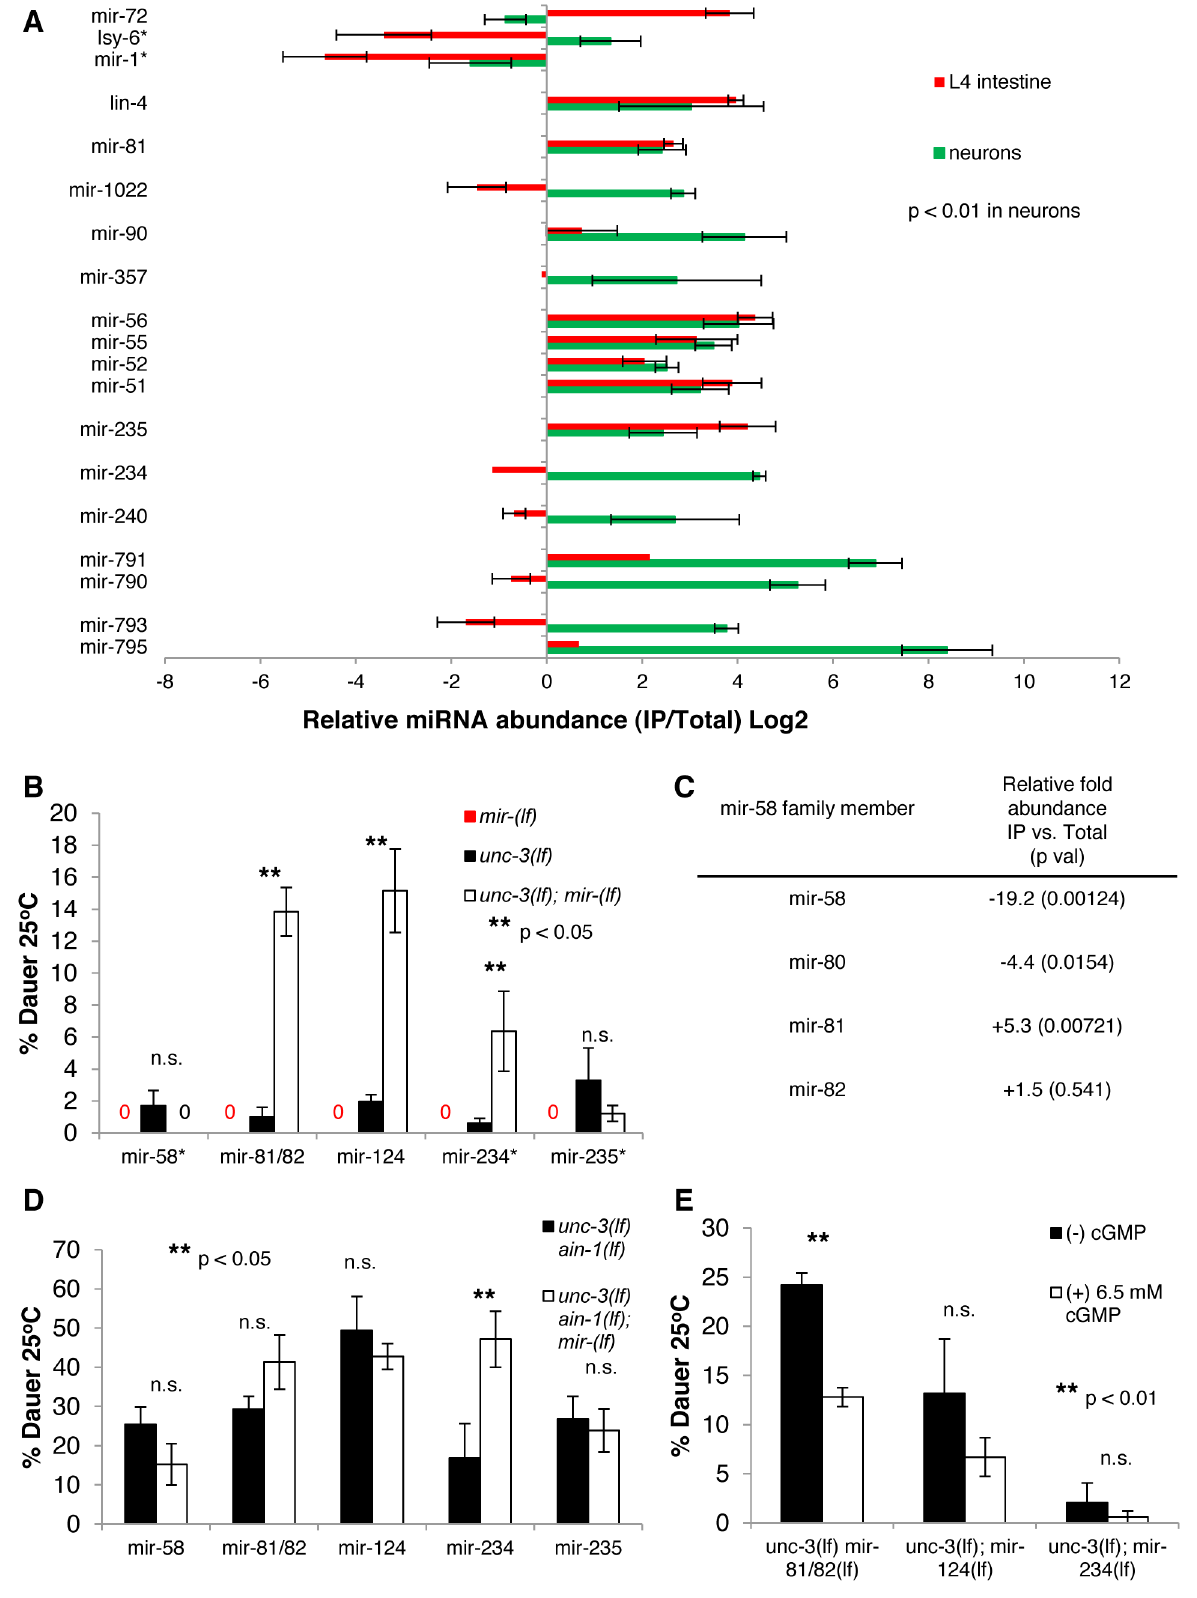
Figure 4. Multiple neuronal miRNAs modulate dauer signaling. A. Bar graph representing the relative abundance of miRNAs enriched in the asynchronous neuronal miRISC IP, with a p , 0.01 determined by a student’s t-test (* except miR-1 and lsy-6). Error bars represent S.E.M. from four biological replicates. B. Bar graph representing the percent of dauer progeny of indicated genotypes. Assays for each unc-3(lf) and unc-3(lf); miR(lf)